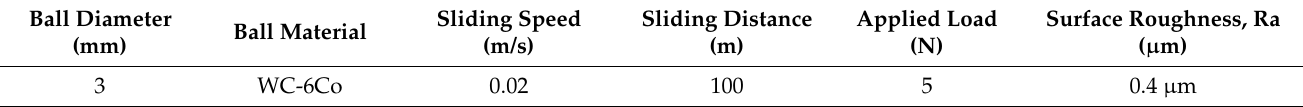
Table 2. Pin-on-disc test